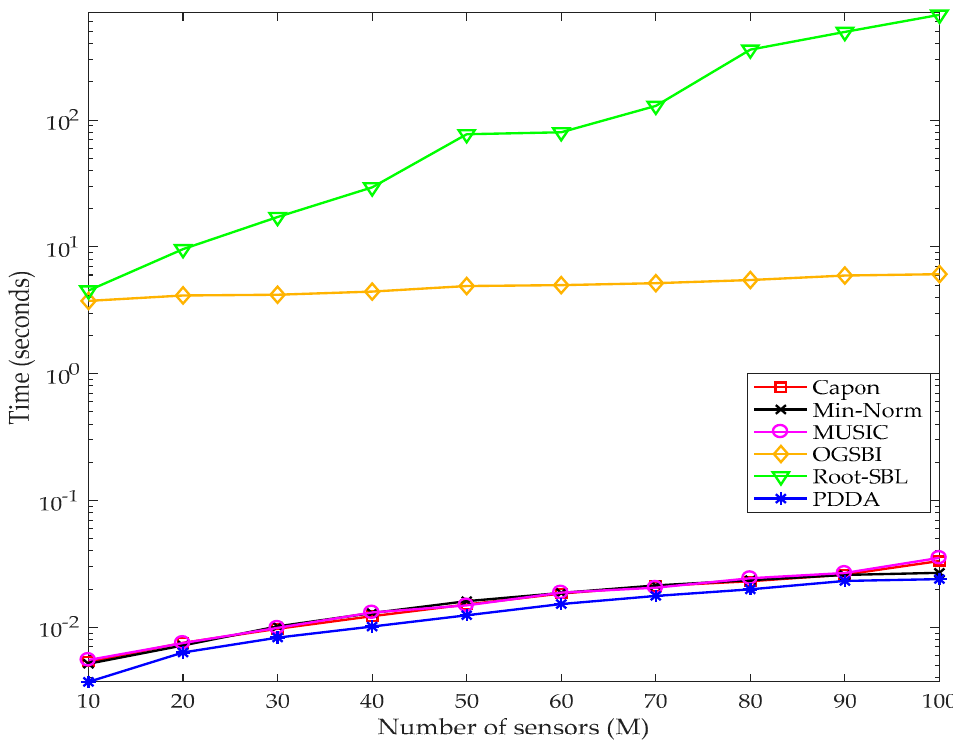
Figure 10. Execution time comparison based on different numbers of sensors.